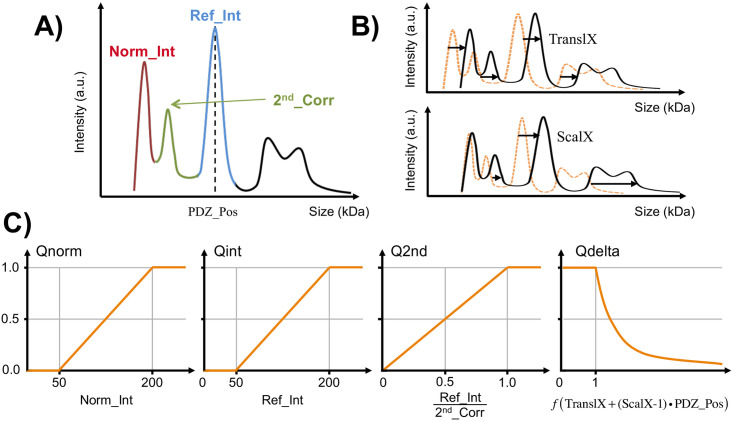
Quality criteria and their conversion to the individual quality scores used to filter the holdup data.(A) A schematized electropherogram showing intensities of the normalization peak (Norm_Int) and of the MBP-PDZ peak (Ref_Int) visible in the red and blue regions, respectively. The region in green corresponds to the proteins of the crude extract, which is supposed to be kept low as compared to Norm_Int and Ref_Int in order to ensure that the MBP-PDZ is not under-expressed (B) The linear transformation used to superimpose the sample and reference electropherograms should be as neutral as possible: The TranslX translation factor and the ScalX scaling coefficient (>1 for dilation or <1 for a contraction) should be as close as possible to 0.0 and 1.0, respectively. (C) Profiles of the individual quality scores used to filter the data. In order to ensure that the analyzed samples were not too diluted, the scores vary linearly between 0 (low quality) and 1 (high quality) for the intensity of the normalization peak (Qnorm) or the MBP-PDZ peak (Qint). Q2nd is a quality score allowing to reject samples with low MBP-PDZ expression while Qdelta combines the TranslX and ScalX parameters and varies exponentially.